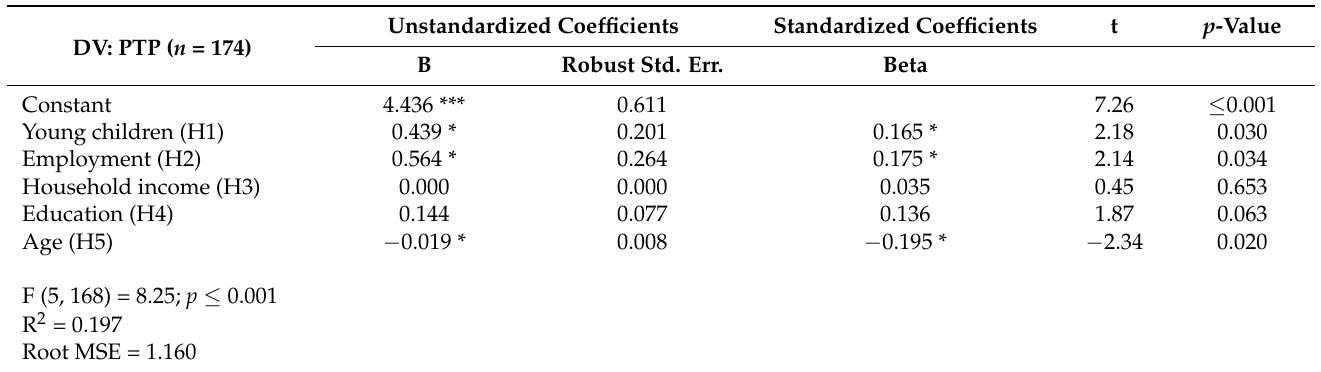
Table 4. PTP for respondents with a non-zero WTP.